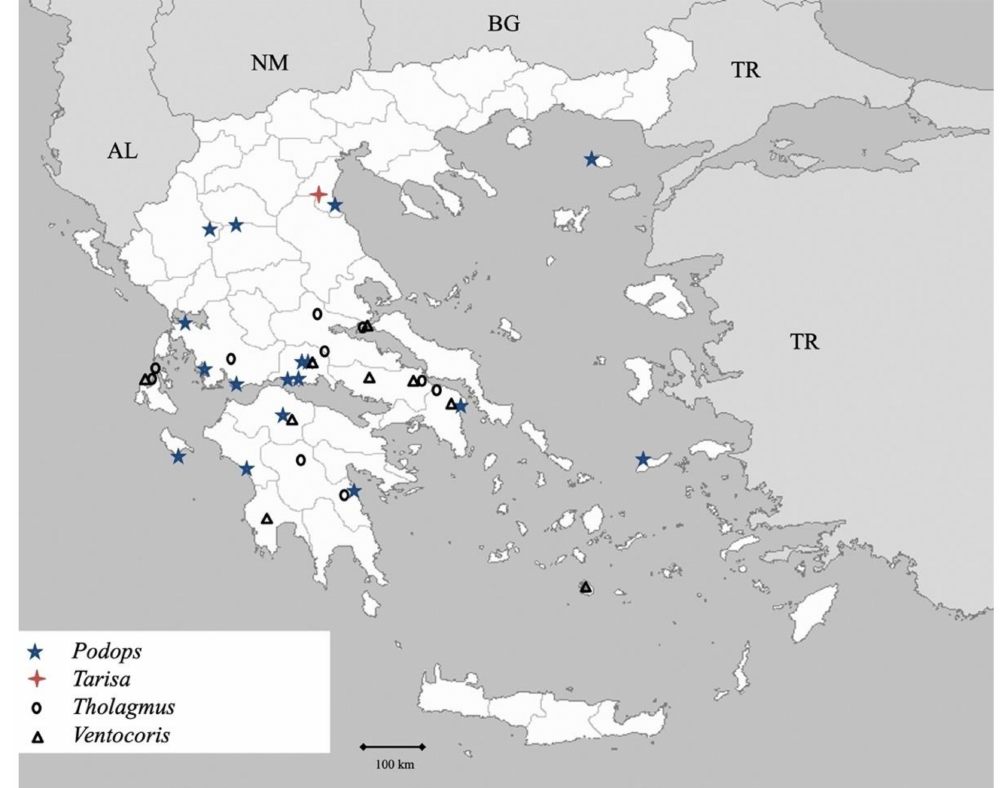
Figure 19. Map showing collecting sites of species of genera Podops, Tarisa, Tholagmus and Ventocoris during the present study in